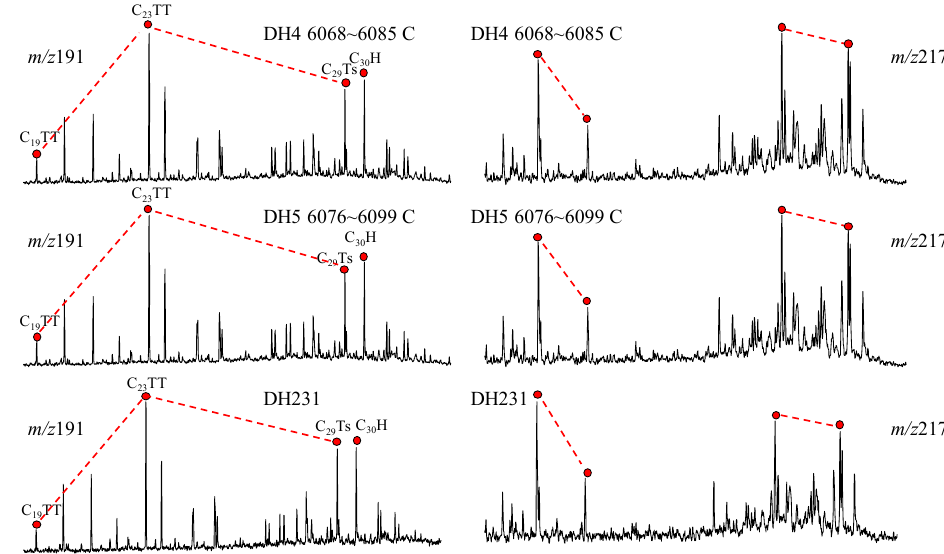
Figure 10. The composition of steranes and terpenoids in the blockade and its comparison with crude oil from adjoining wells .